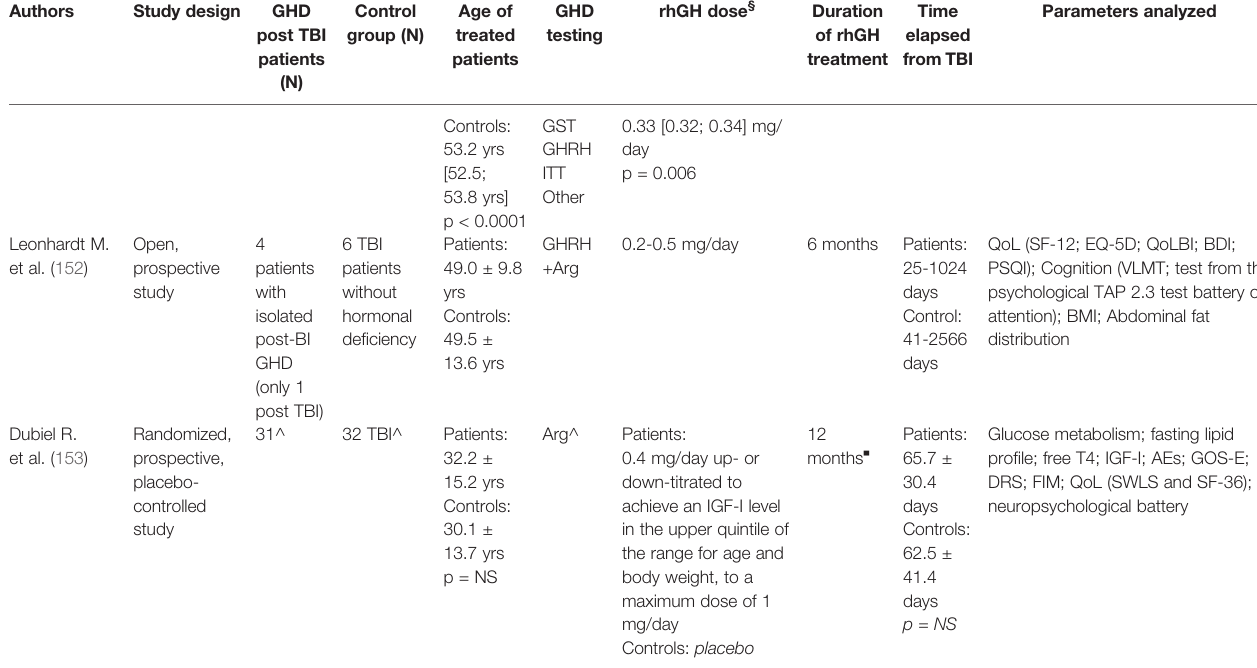
Figure Test; rhGH, recombinant human GH; SCL-90-R, Symptom-check-list; SF-12, 12-Item Short Form Health Survey; SF-36, Short-Form 36; SWLS, Satisfaction with Life Scale; TAP, Test for Attentional Performance; TBI, traumatic brain injury; Tinetti, balance and gait tests; TMT, Trail Making Test; VLMT, Verbal Learning and Memory Test; VO 2 , peak